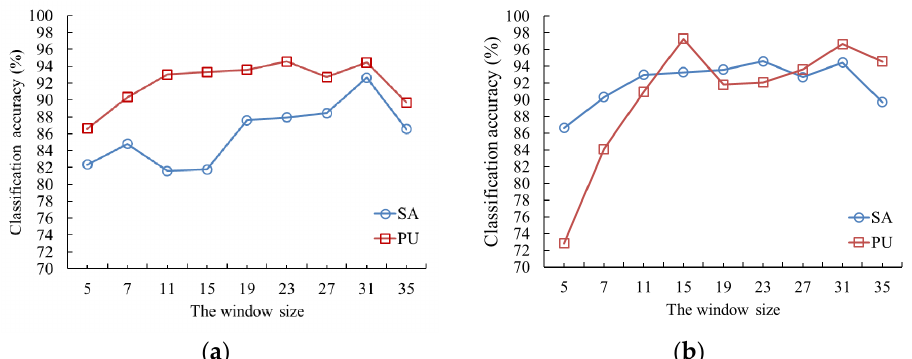
Figure 7. The influence of the input window size on the overall classification accuracy of CNN and Caps method for both SA and PU datasets. ( a ) The influence of the input window size of CNN, and ( b ) the influence of the input window size of Caps.